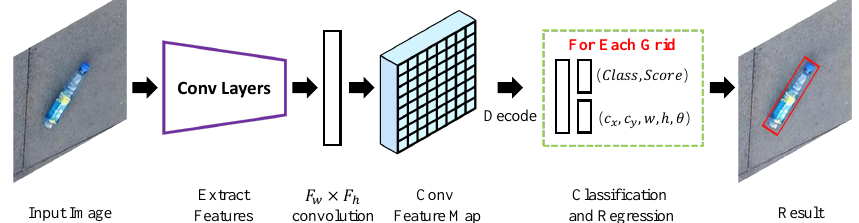
Figure 7. Rotation-SqueezeDet’s detection